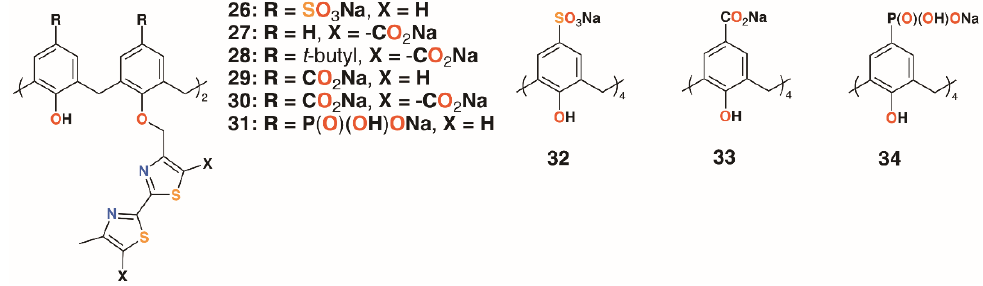
Figure 8. Regnouf-de-Vains’ anti-HIV calixarene prodrugs.